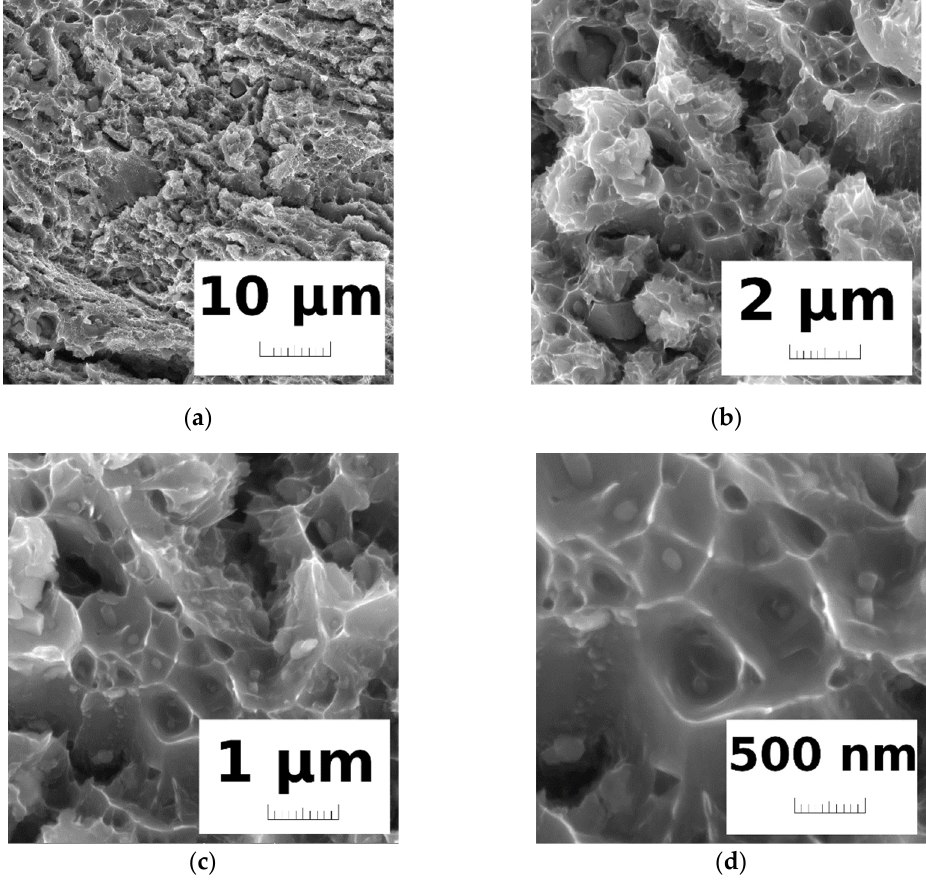
Figure 12. Fracture topography micrographs of SPS-KOBO extruded AA7075 after tension test with various magnification: 5 kx ( a ); 25 kx ( b ); 50 kx ( c ); 100 kx ( d ).